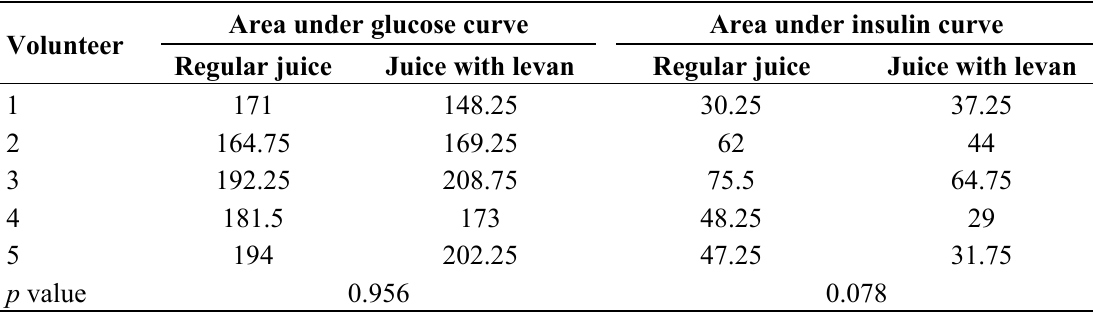
Table 5. Glycemic index of levan-enriched and regular